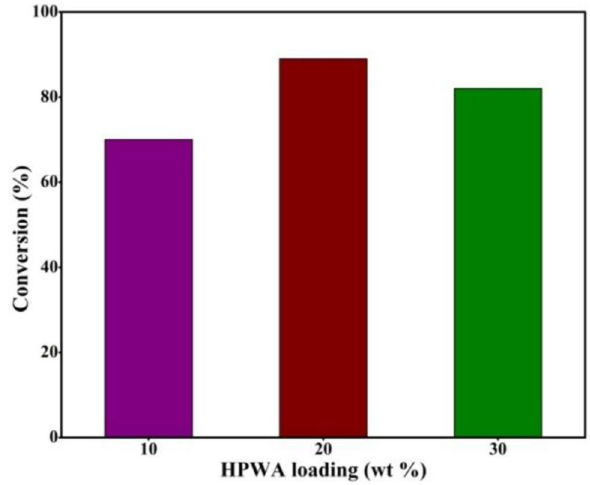
Fig. 9 Influence of HPWA loading over KIT-6 in the transesteri- fication of neem oil [Reaction condition: catalyst, 0.35 g; oil, 10 g; 60 °C; run time, 3 h; MeOH/oil (mole), 10]